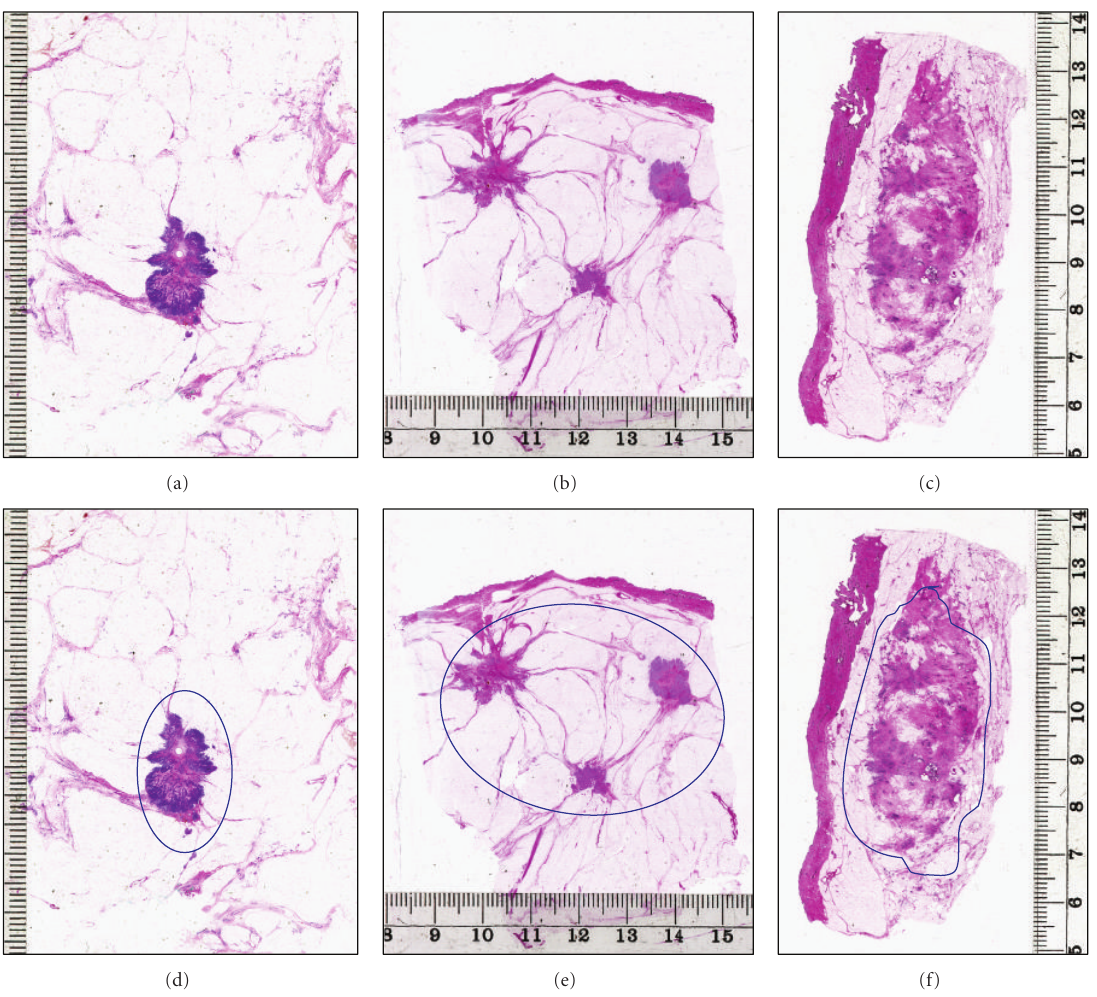
Figure 2: The three basic growth patterns of invasive breast carcinoma. Upper left: unifocal; upper central: multifocal; upper right: di ff use growth pattern. The extent of the disease is marked in the lower series of